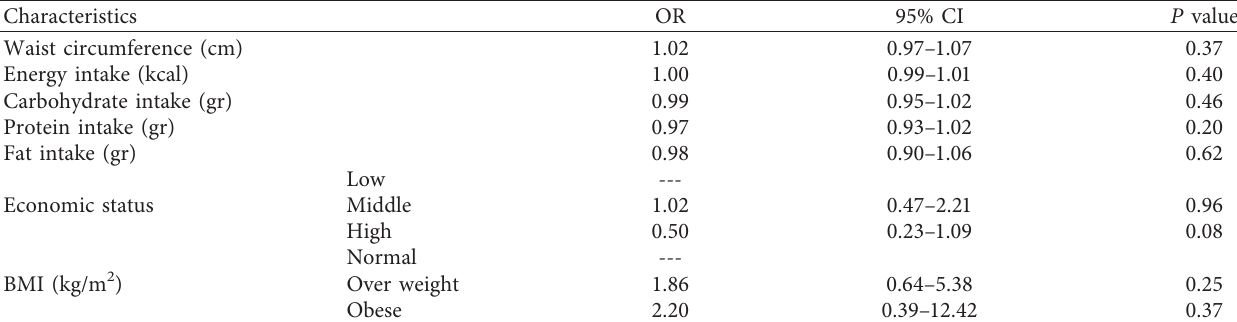
Table 5: Logistic regression model showing the most associated factors on menstrual disorders.